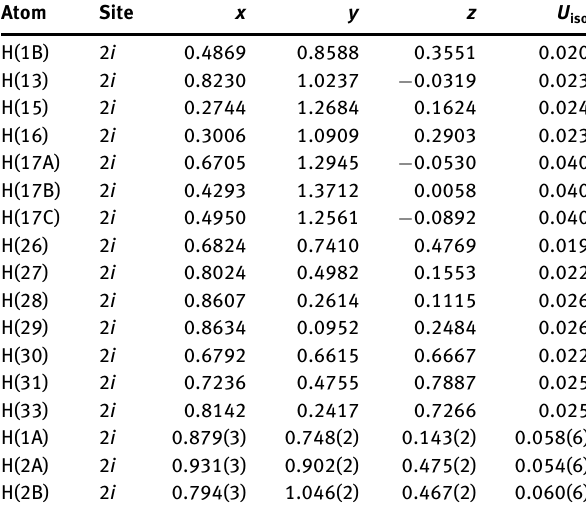
Table 2: Fractional atomic coordinates and isotropic or equivalent isotropic displacement parameters (Å 2